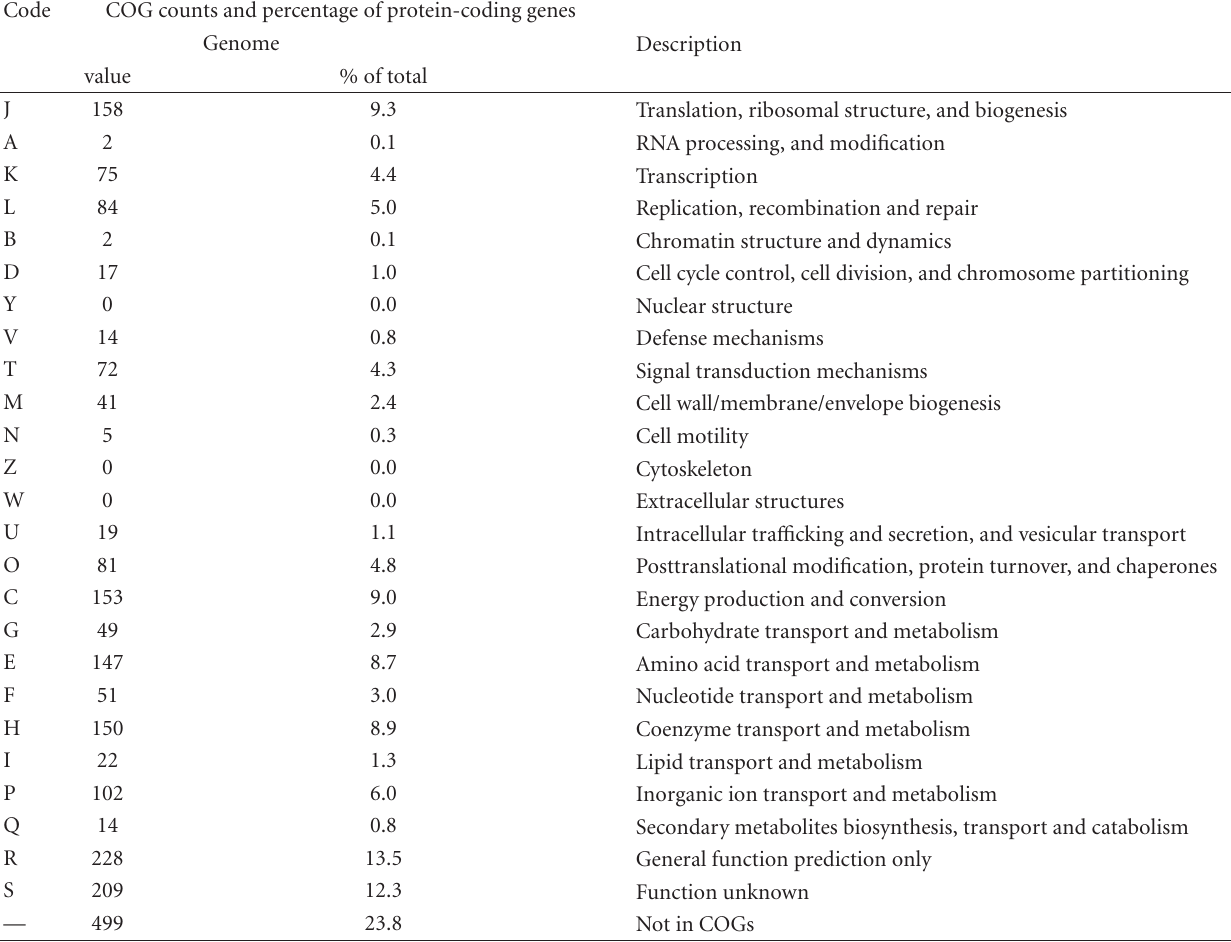
Table 2: Number of genes associated with the general COG functional